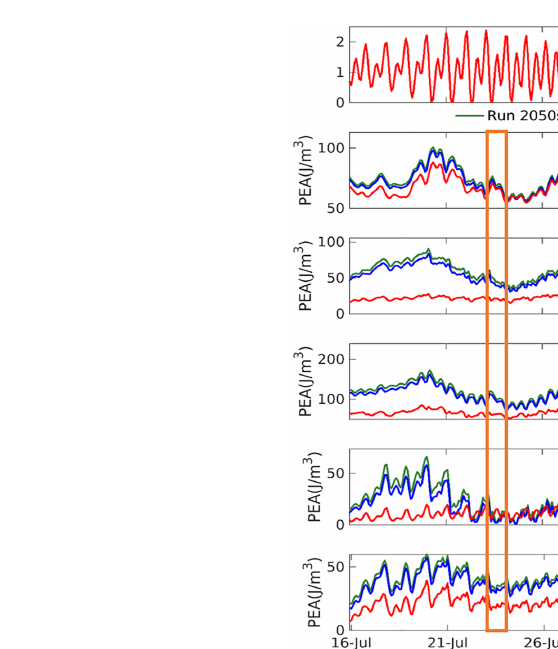
the advection term (Equation 4) increases by about three times during the transition from neap tides to spring tides. It can be seen in Figure 6 that the advection of the horizontal gradient of salinity variance is the main contributor to strati fi cation. During the advection process, the vertical salinity variance ( S 0 v ) 2 increases signi fi cantly (by about 200% on average) with a strong saltwater intrusion from the bottom, resulting in an import of salinity variance to the Lingding Bay.